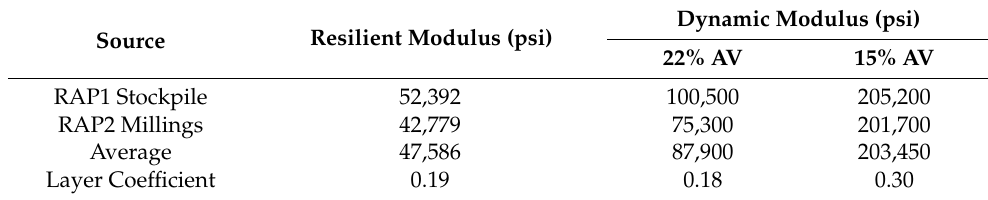
Table 7. Summary of modulus and layer